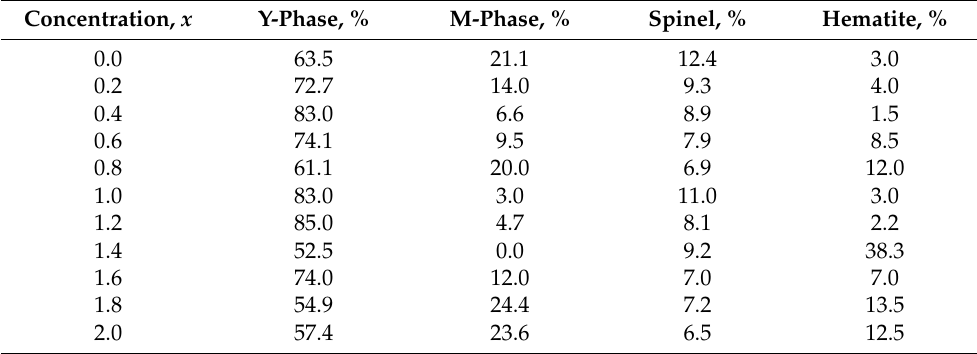
Table 1. Phase composition of synthesized samples Ba 2 Ni 2- x Cu x Fe 12 O 22 . Concentration,